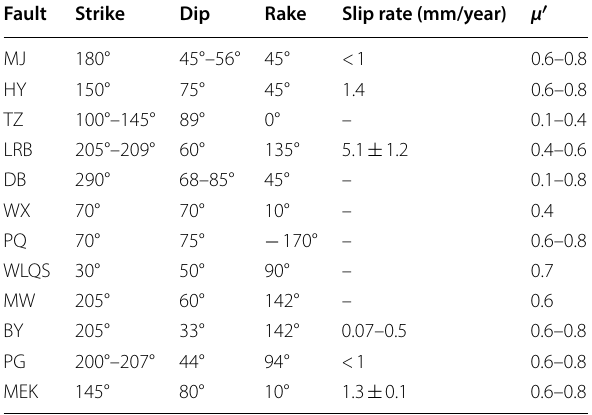
Table 5 Parameters of the major faults in the study area